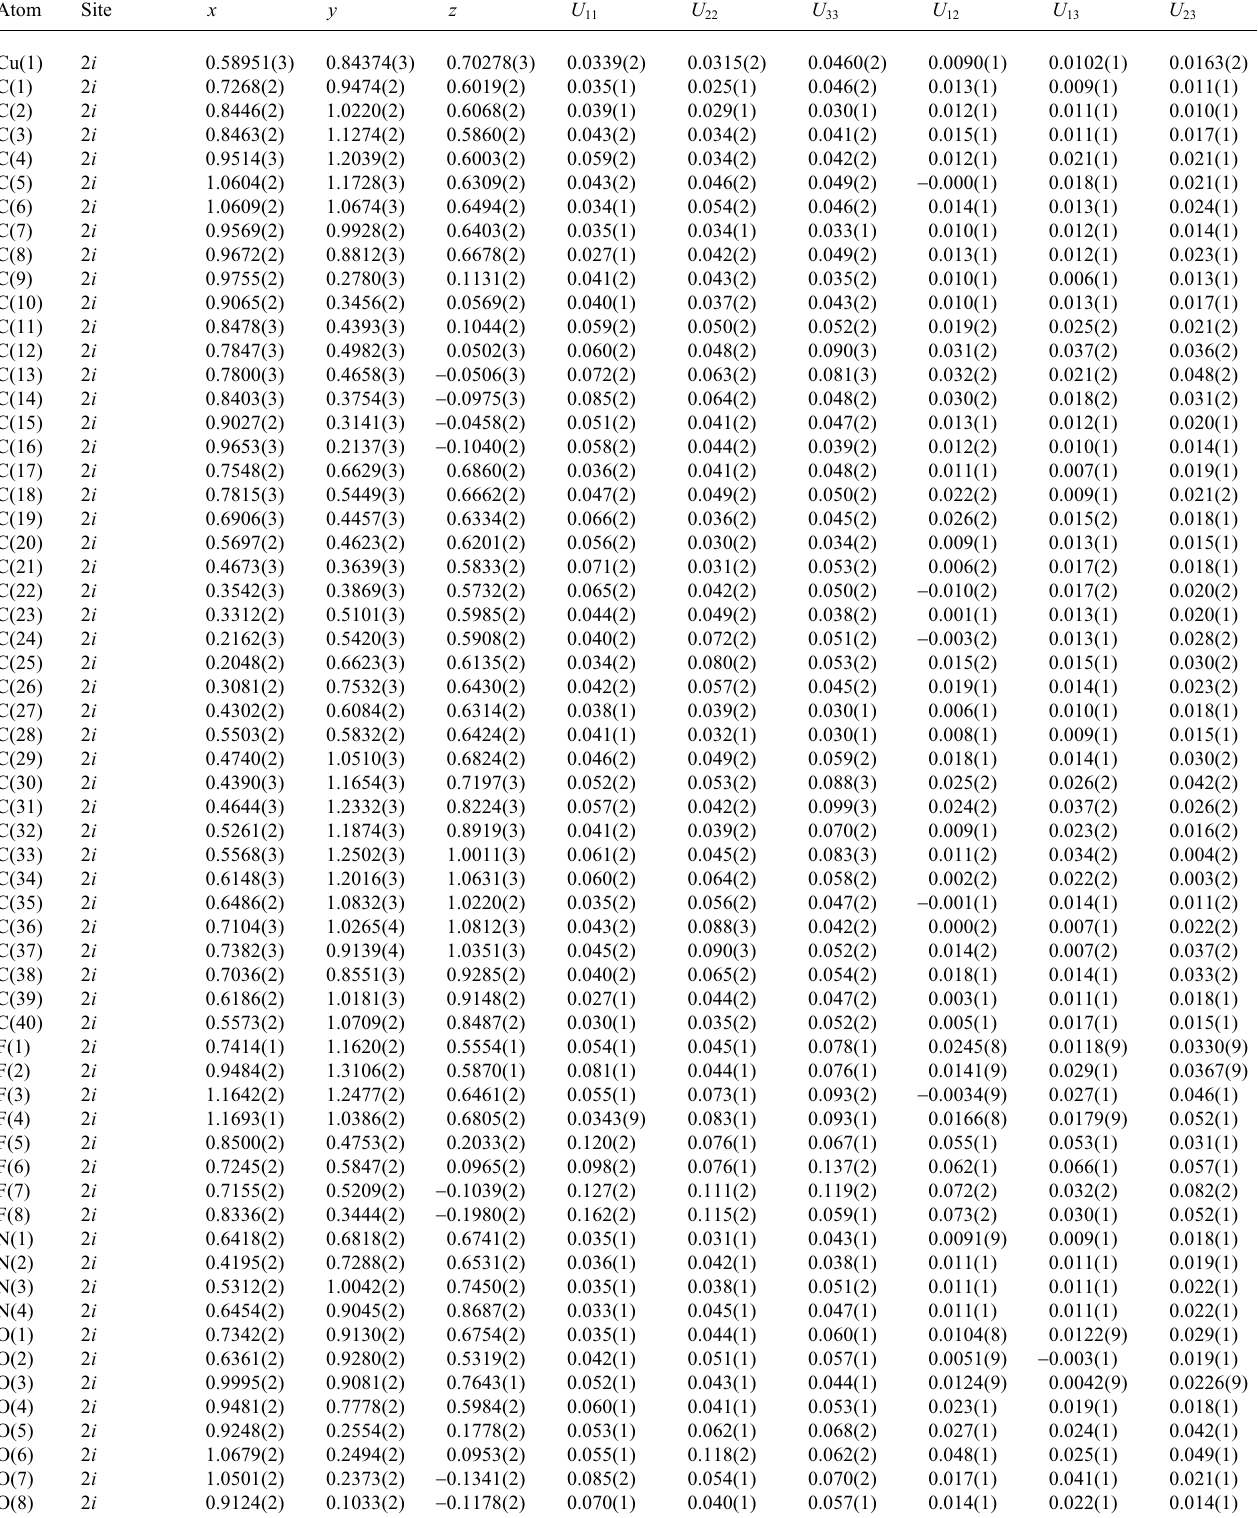
Table 3. Atomic coordinates and displacement parameters (in Å 2 )